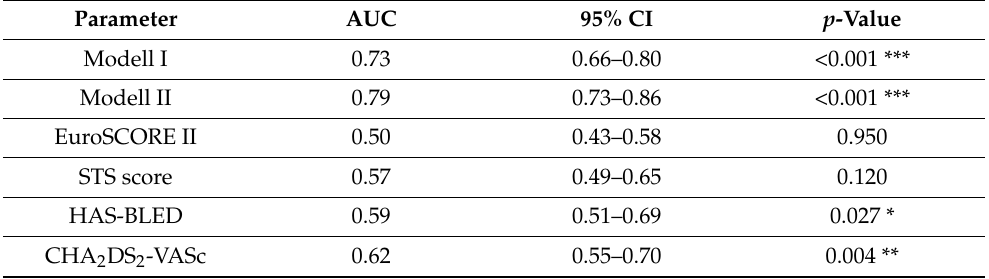
Table 5. Comparison of risk scores in CVE prediction after TAVR (derivation cohort).